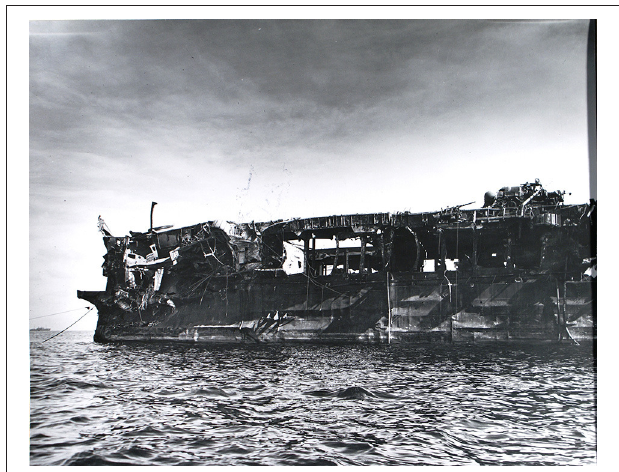
FIGURE 4 | Damage to USS Independence , documented after Operation Crossroads (U.S. National Archives).